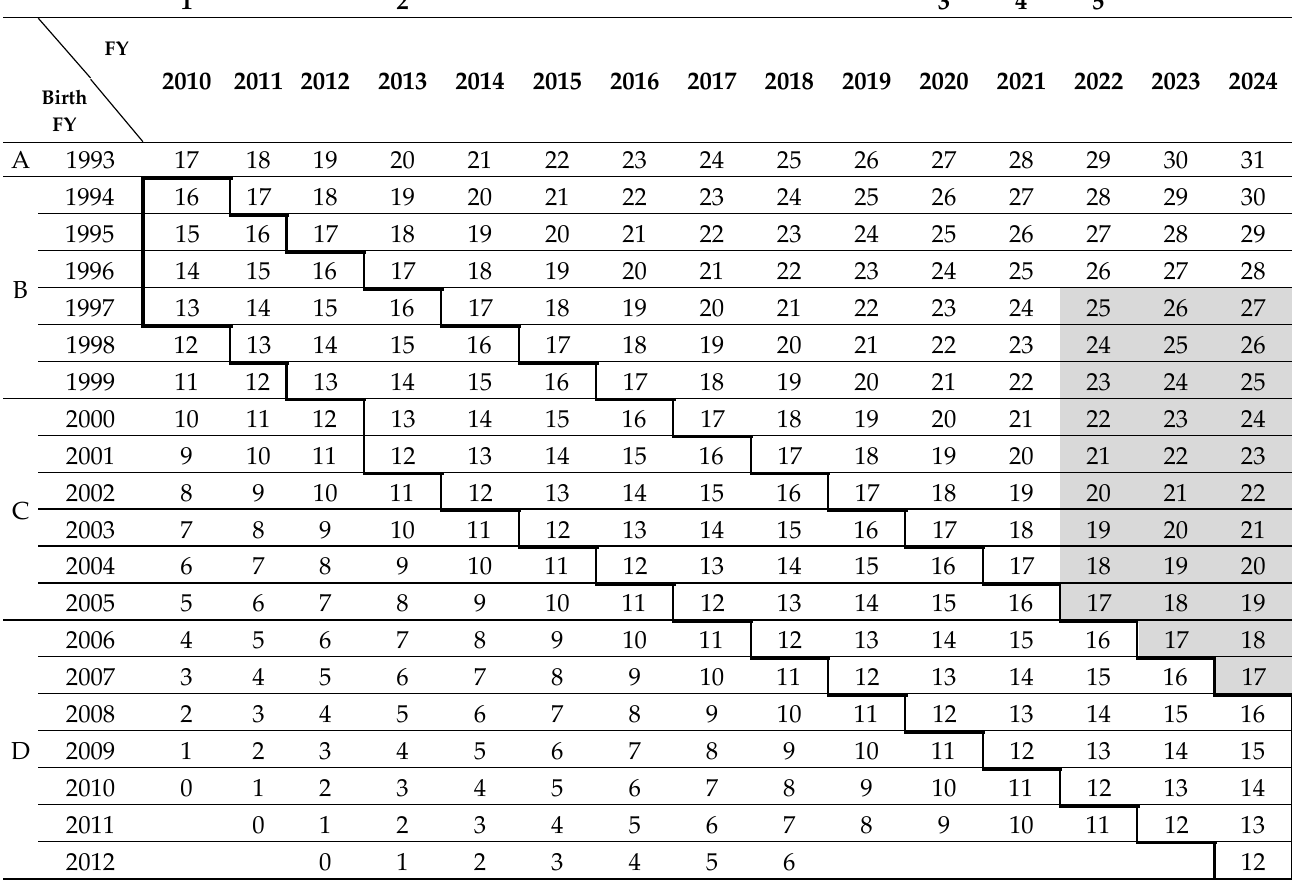
Bold line frame: Eligibility for subsidies and national immunization programs; Cells in gray: Eligibility for catch-up vaccination. Major policy makings related to HPV vaccine: 1. November 2010: Subsidies from local